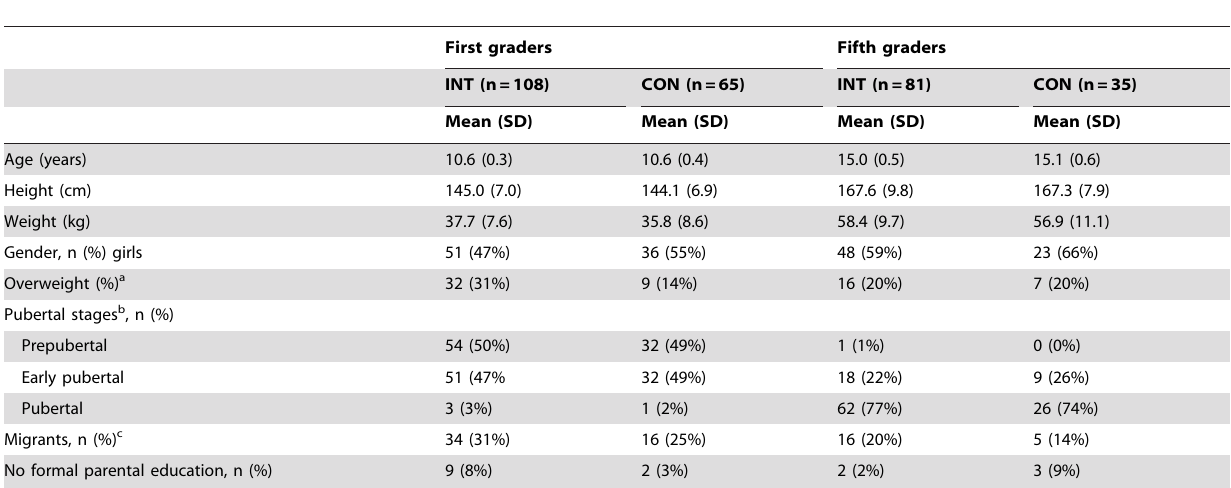
Table 2. Follow-up characteristics of participating children according to treatment arm. Values are means (SD) unless stated otherwise.